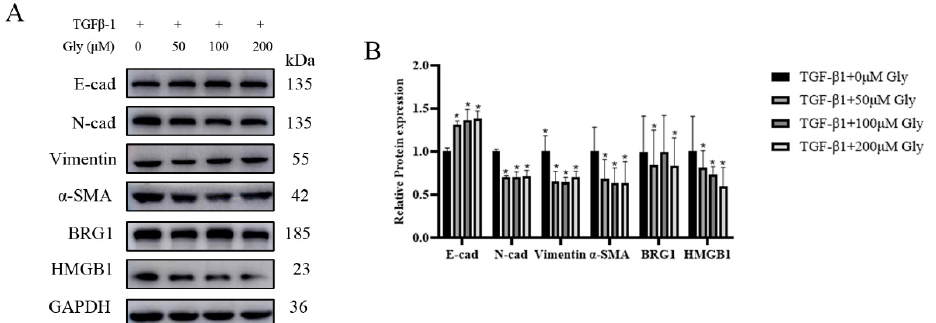
Figure 5. Different concentrations of glycyrrhizic acid could inhibit the EMT-like changes caused by TGF- β 1. After A549 cells were treated with different concentrations of glycyrrhizic (0, 50, 100, 200 μ M) acid for two hours, the culture medium containing 5 ng/mL TGF- β 1 was changed, and then the EMT markers were detected. ( A ) The expression of E-cad, N-cad, Vimentin, α -SMA, HMGB1, BRG1, and GAPDH were detected by Western blotting. ( B ) Quantification. Shown are the averages of three independent experiments. GAPDH was used as an internal control *: p < 0.05 compared with the TGF- β 1+0 μ M Gly group.